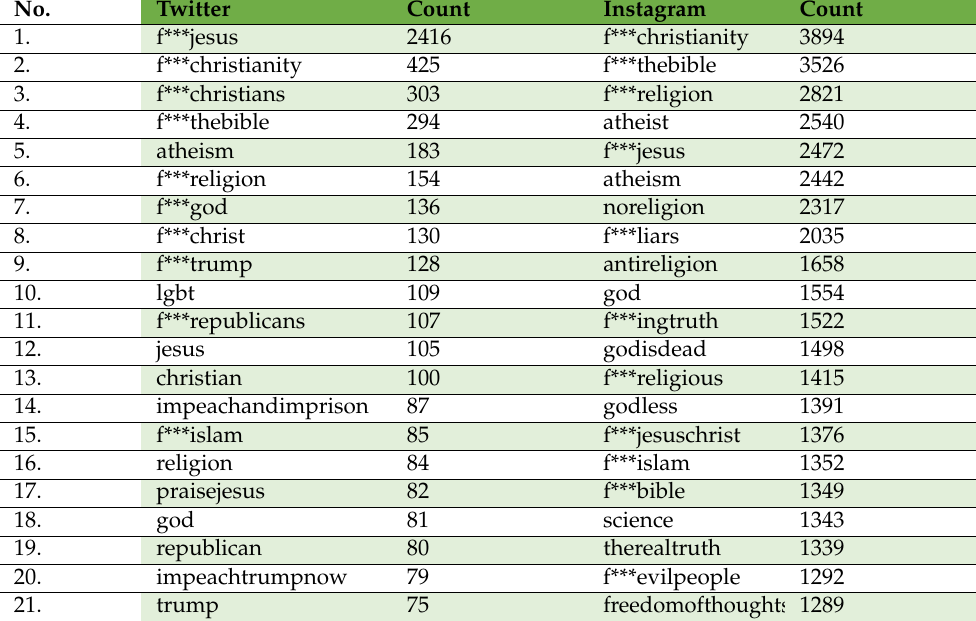
Table 4. The most frequent hashtags on Instagram and Twitter in relation to Christianity.